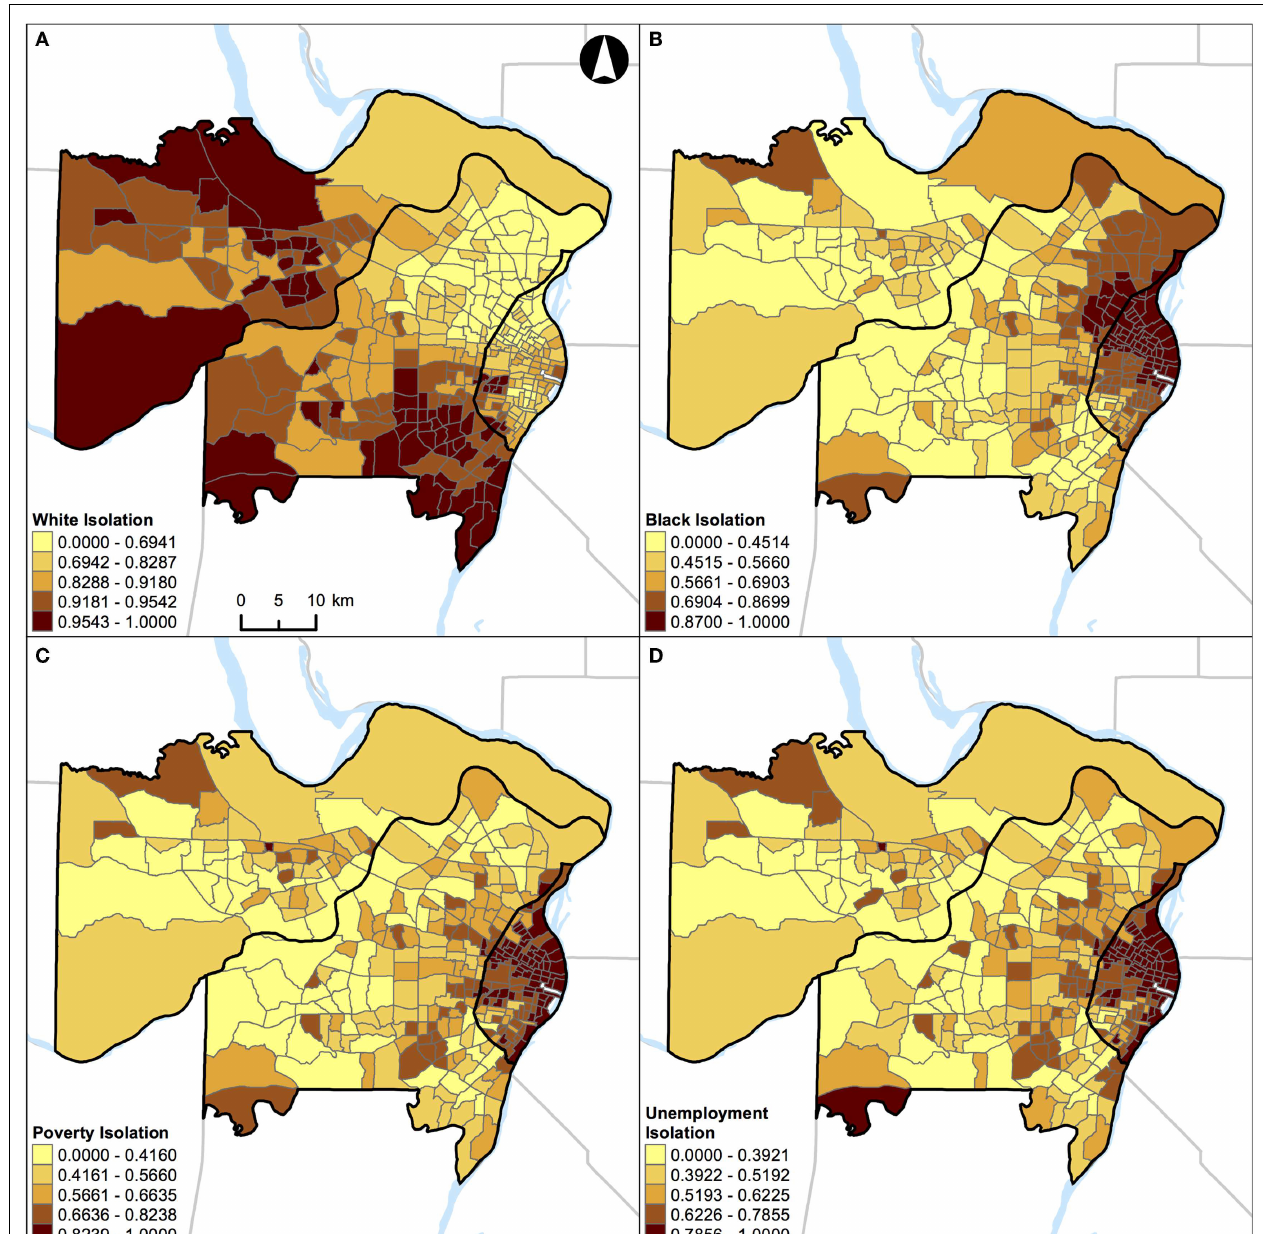
FIGURE 6 | Geographic distribution of local spatial isolation measures in St. Louis, MO, USA (340 census tracts) . (A) White isolation, (B) black isolation, (C) poverty isolation, and (D) unemployment isolation. A quantile classification scheme was used to display the levels of local